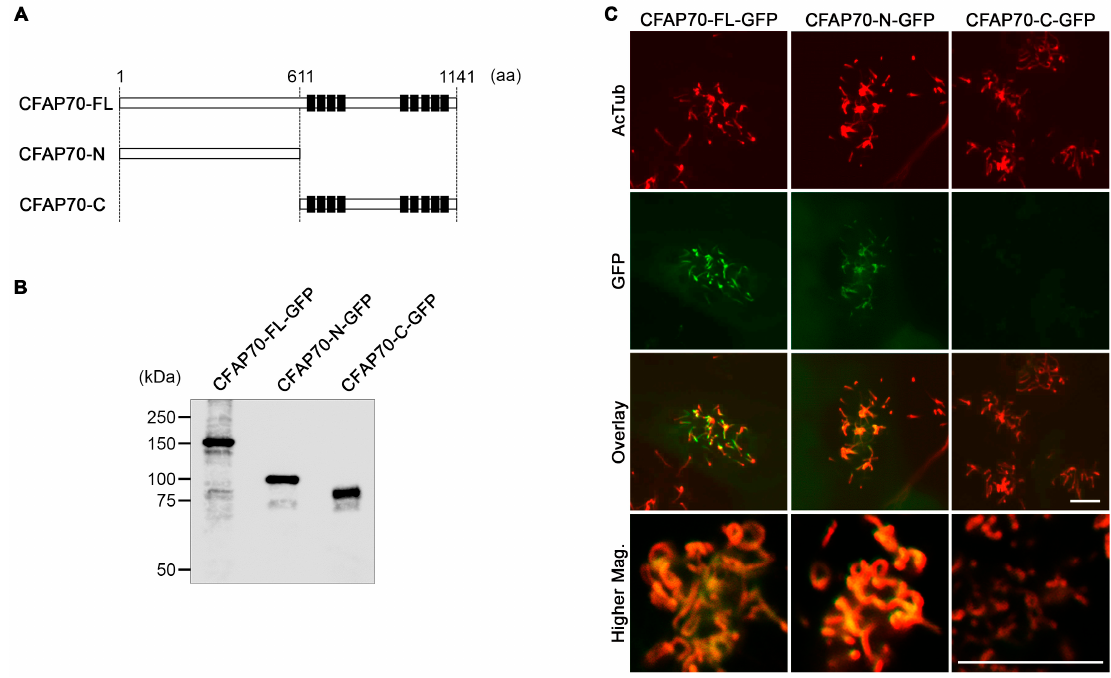
Figure 3. Changes in the ciliary localization of CFAP70 fragments in primary culture of mouse ependyma. ( A ) Schematic diagrams of mouse CFAP70 protein and its deletion constructs made in this study. The 1141-amino-acid protein has clusters of tetratricopeptide repeat (TPR) domains (indicated by filled boxes) at the C-terminal half. ( B ) Western blot analysis for validation of the expression of recombinant CFAP70 proteins fused with a GFP tag at the C-terminus. 293T cells were transfected with the lentiviral expression plasmids and the whole cell lysates were analyzed. The calculated molecular weights are as follows: CFAP70-FL-GFP, 155 kDa; CFAP70-N-GFP, 95 kDa; CFAP70-C-GFP, 87 kDa. To the left of the gel, the positions and sizes (kDa) of molecular weight standards are indicated. ( C ) Confocal microscopy of cultured ependyma transduced with lentiviral particles carrying the above constructs. The cells were immunostained for AcTub (red) and GFP (green). Bars, 10 µm.